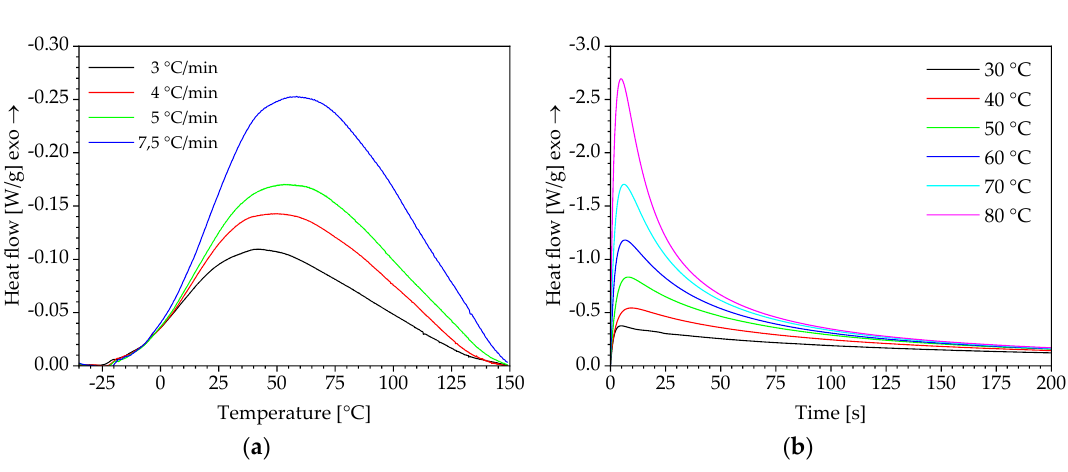
Figure 3. Thermograms of the curing reaction under: ( a ) non-isothermal and ( b ) isothermal conditions. During the interpretation of curing processes, the effect of vitrification must be taken into account.